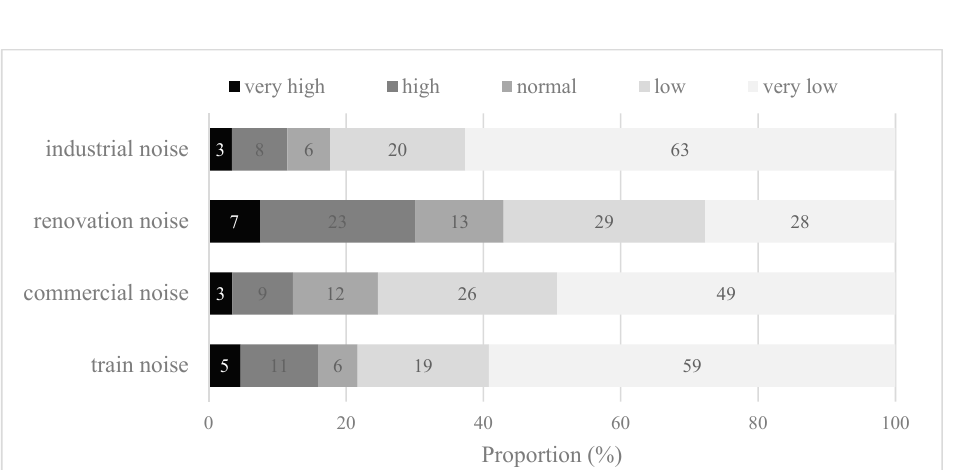
Figure 2. Population (%) in perceived noise-pollution levels of different categories.